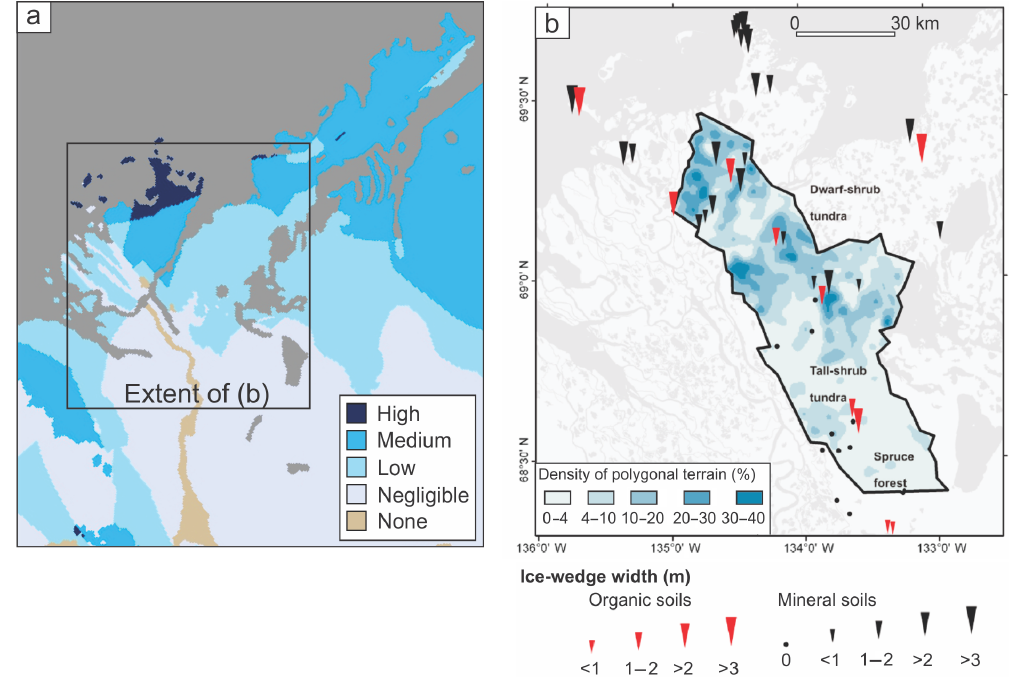
Figure 7. Comparison of (a) modelled wedge ice abundance to (b) wedge widths and the density of polygonal terrain in the western Canadian Arctic (modified from Kokelj et al., 2014, Fig.